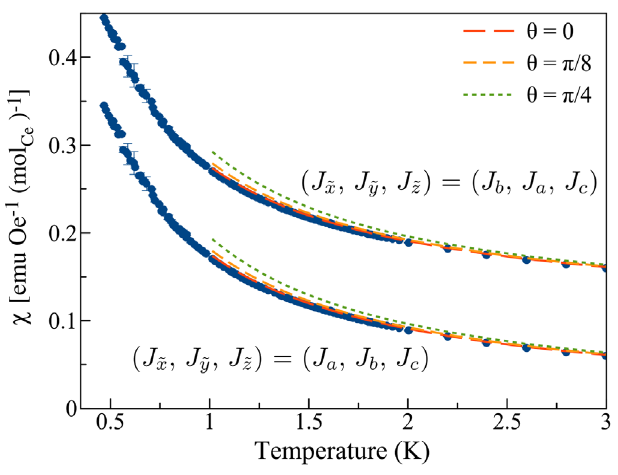
FIG. 7. The measured powder magnetic susceptibility data plotted alongside the second-order NLC-calculated susceptibility ; J ˜ ; J ˜ for values of θ between 0 and π = 4 , and for ð J ˜ equal x y z Þ to the two permutations of the A parameters that are able to provide a reasonable fit to the data. Specifically, we show calculations for values of θ given by θ ¼ 0 (red), θ ¼ π = 8 (yellow), and θ ¼ π = 4 (green). This shows that the NLC calcu- lations for the magnetic susceptibility agree well with the data 0 . 064 ; 0 . 063 ; 0 . 011 Þ meV, or ð J ; J ˜ ; J ˜ when ð J ˜ ˜ x ; J ˜ y ; J ˜ z Þ ¼ x y z Þ ¼ ð ð 0 . 063 ; 0 . 064 ; 0 . 011 Þ meV, so long as the value of θ is near θ ¼ 0 . The ð J 0 . 063 ; 0 . 064 ; 0 . 011 Þ meV calculations ˜ x ;J ˜ y ;J ˜ z Þ ¼ ð − 1 for are shifted upward by 0.1 emu Oe − 1 ð mol Ce Þ